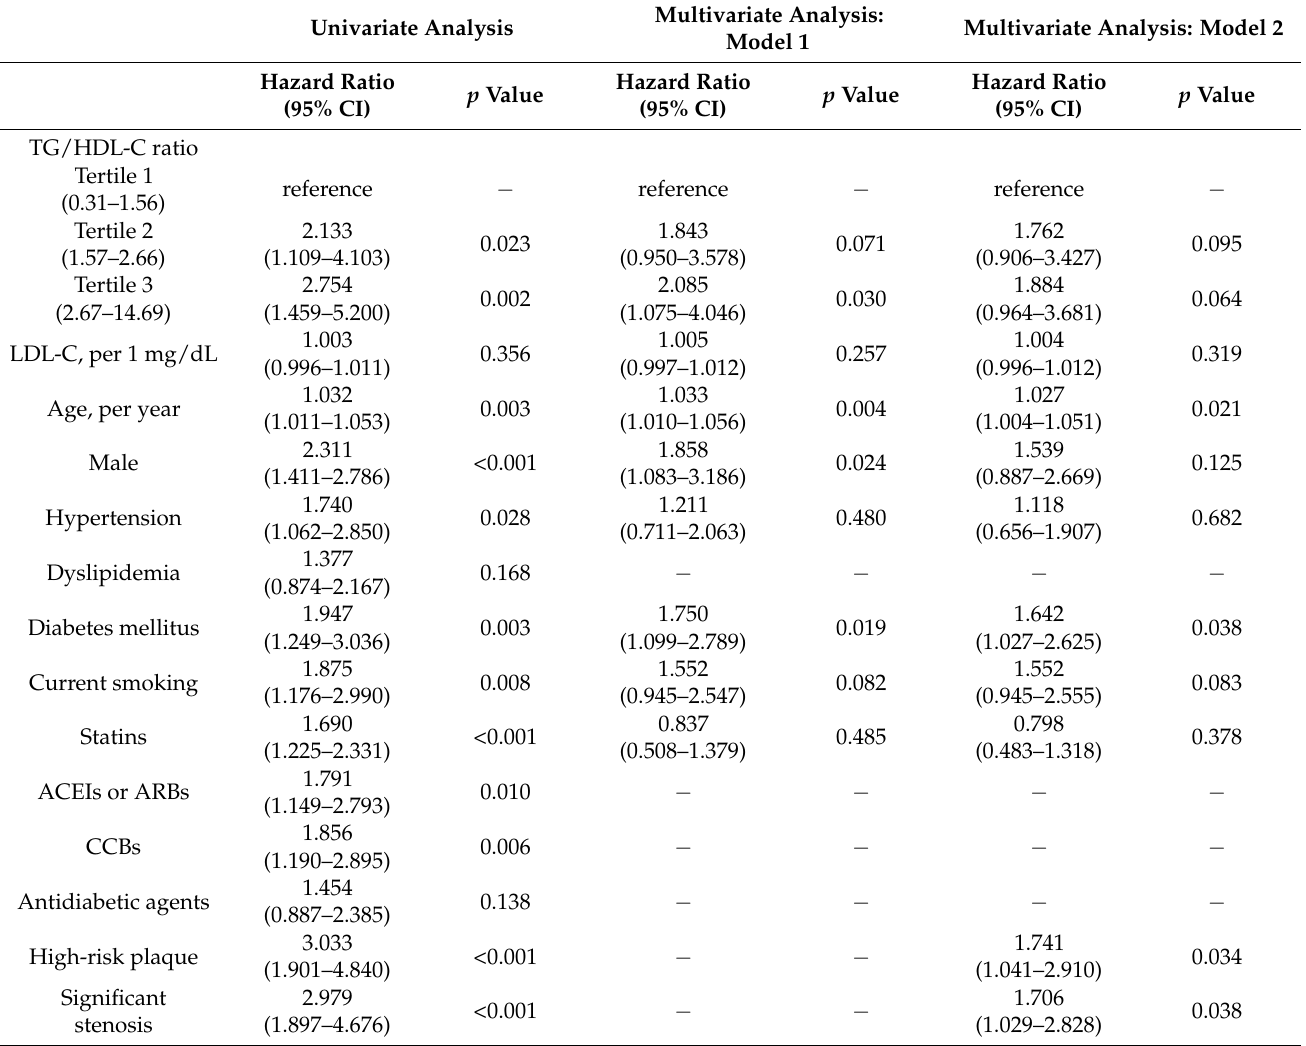
Table 6. Univariable and multivariable associates of the secondary